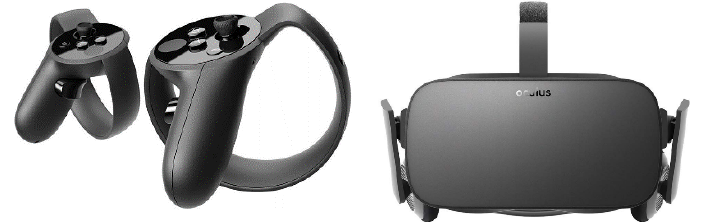
Figure 1. Head mounted display and controllers.